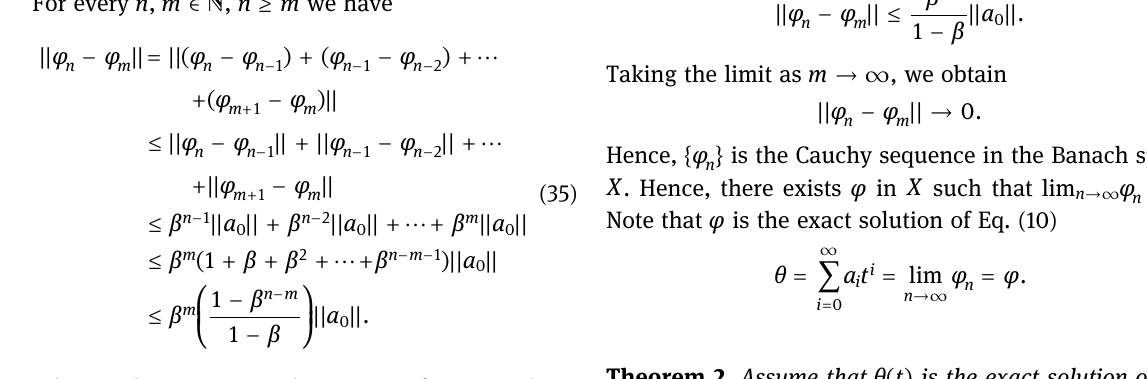
25 ⟨ ⟩ with step - size h 0.25 = ( dots ) . ( c ) Absolute error when we compare k